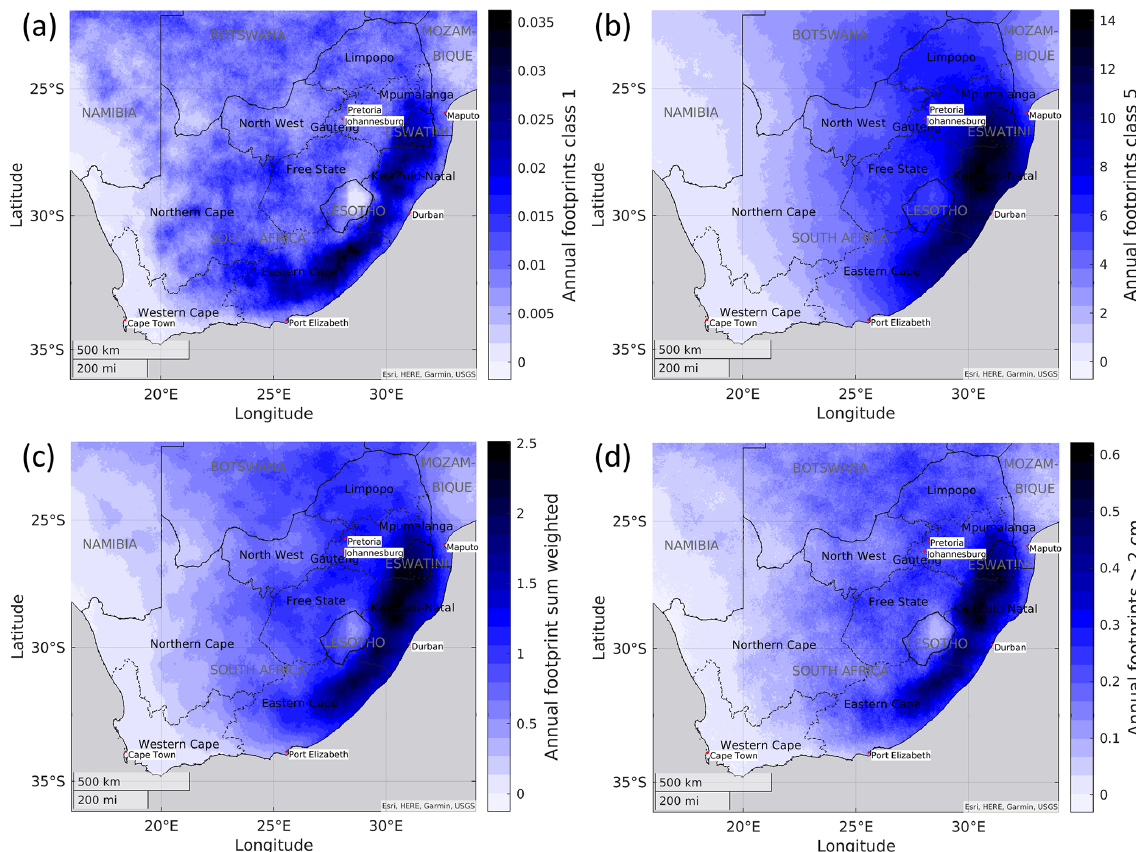
Figure 18. Number of events hitting a grid cell per year (a, b) : for classes 1 and 5, respectively; (c) total, frequency-weighted; (d) as (c) but for hail diameter > 2cm. Port Elizabeth is now